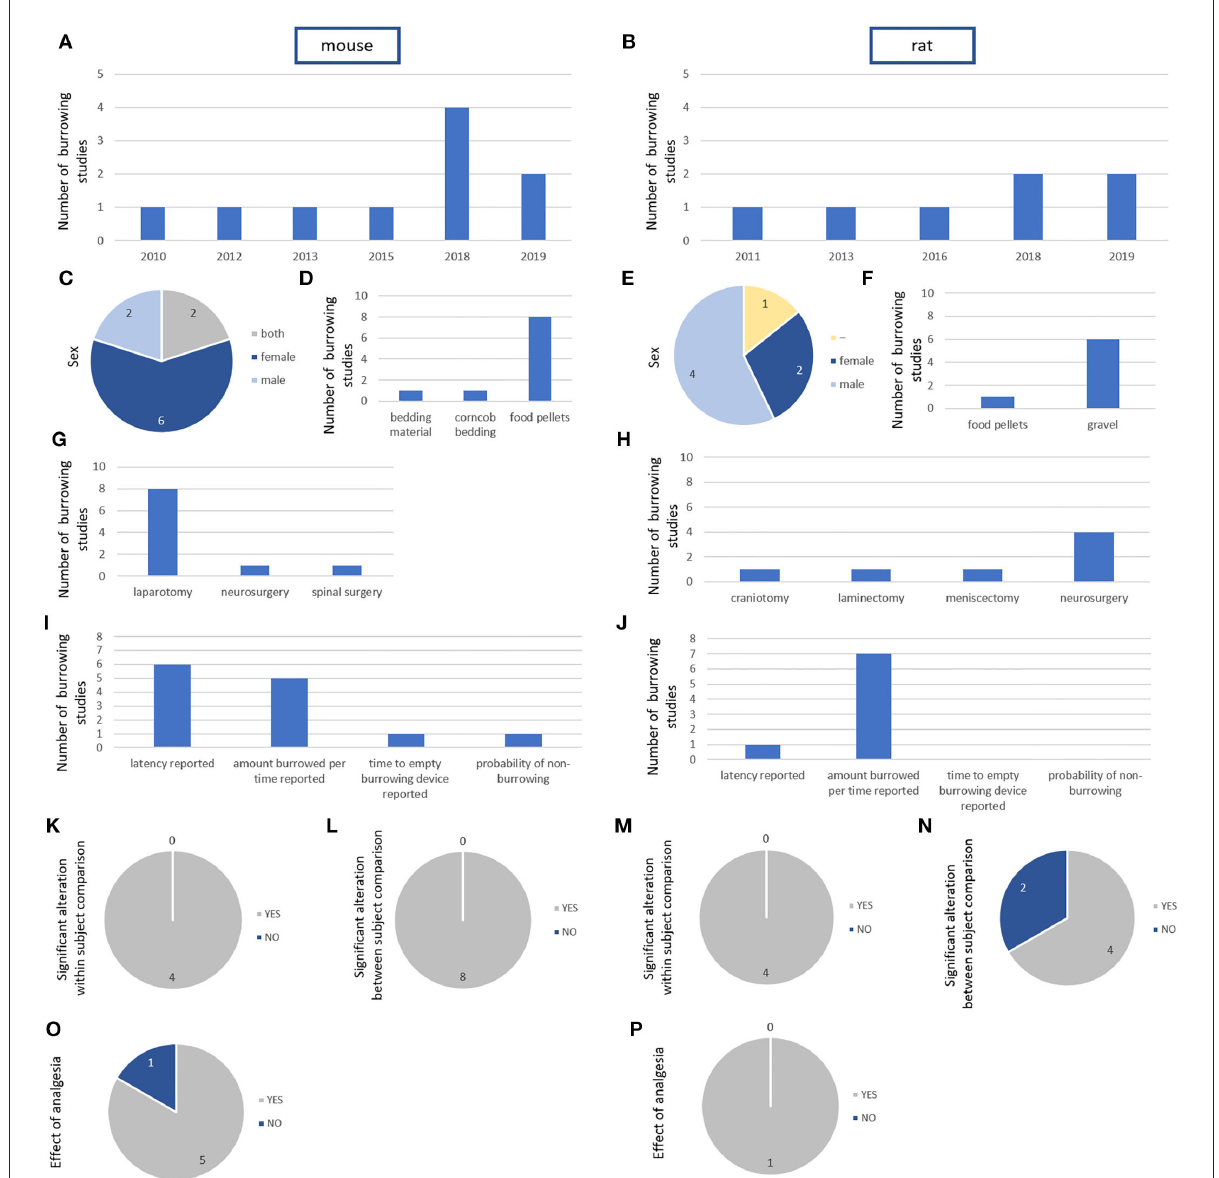
FIGURE4 Study characteristics, animal characteristics, and intervention characteristics for burrowing in mice (k = 10 studies) and rats (k = 7 studies). (A,B) Number of published studies using burrowing for the assessment of post-surgical-pain in mice (A) and rats (B) during the last decade. X-axis represents years. (C,E) Number of burrowing studies in mice (C) and rats (E) using females, males, and both sexes. (D,F) Used burrowing material in mice (D) and rats (F) . (G,H) Type of intervention in mice (G) and rats (H) . (I,J) Reported burrowing parameter in mice (I) and rats (J) . (K,M) Studies describing within-subject comparison in mice (K) and rats (M) . The within-subject comparison revealed an influence of the surgical intervention in all mouse and all rat studies. (L,N) Studies describing between-subject comparison in mice (L) and rats (N) . The between-subject comparison revealed an influence of the surgical intervention in all mouse studies. (O,P) Studies describing an analysis of the impact of an analgetic drug in comparison with a control group in mice (O) and rats (P) . The analysis revealed an influence in all rat